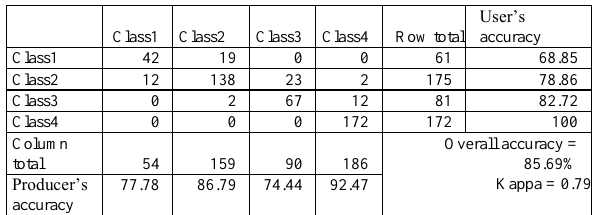
Table 2. Confusion matrix of the Maximum Likelihood